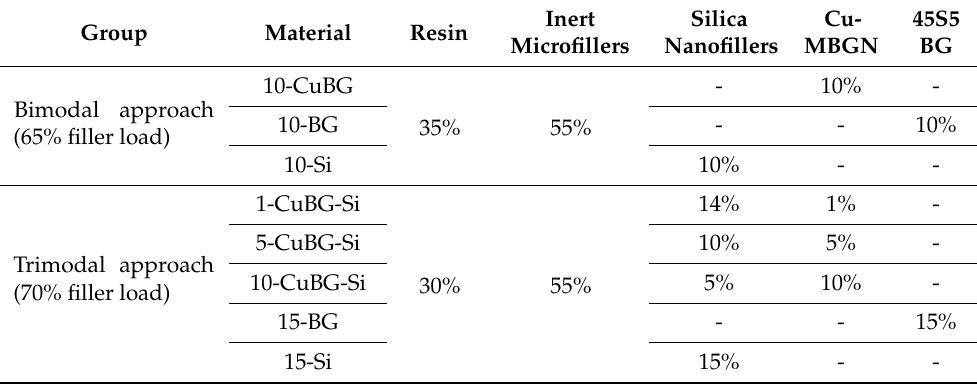
Table 2. Composition of experimental resin composites (all amounts in wt